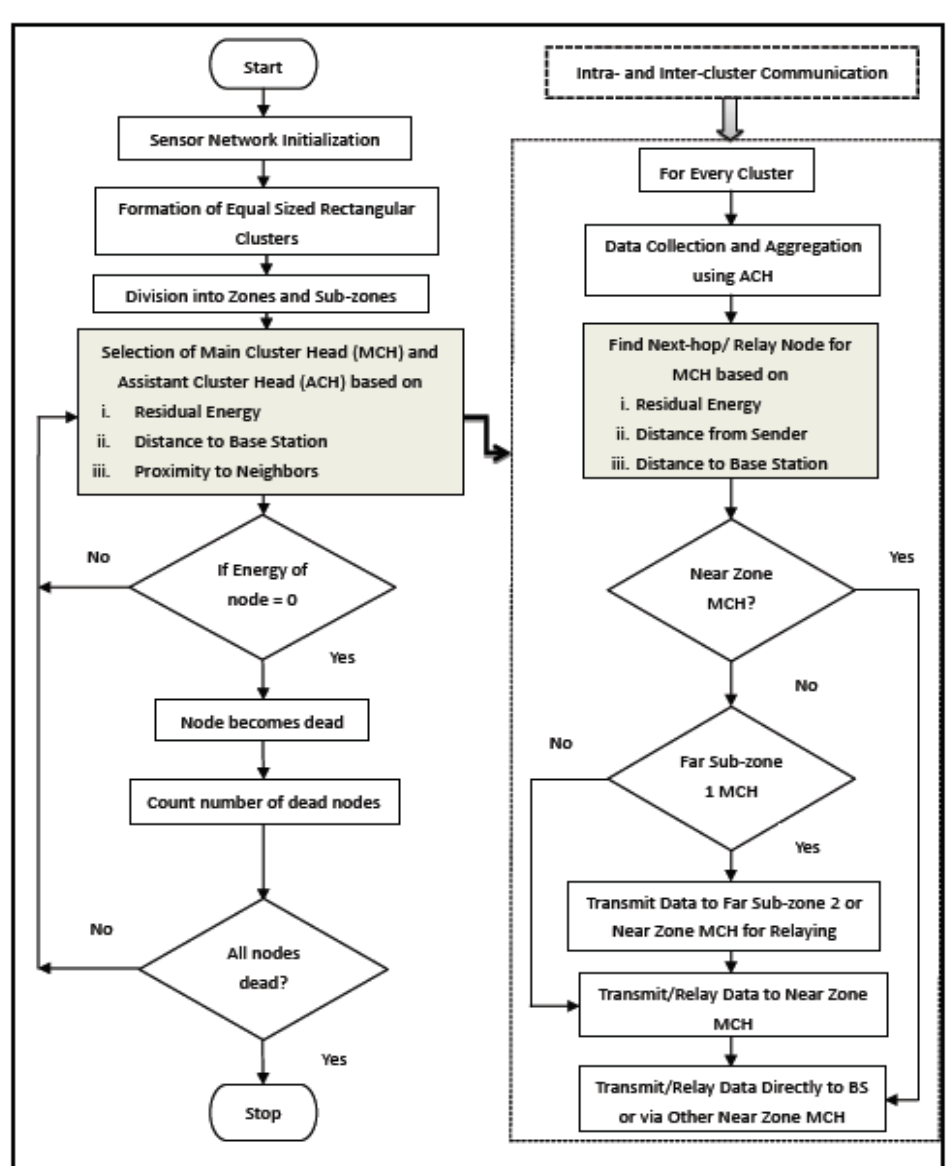
Figure 4. Flowchart of the process flow in clustering.